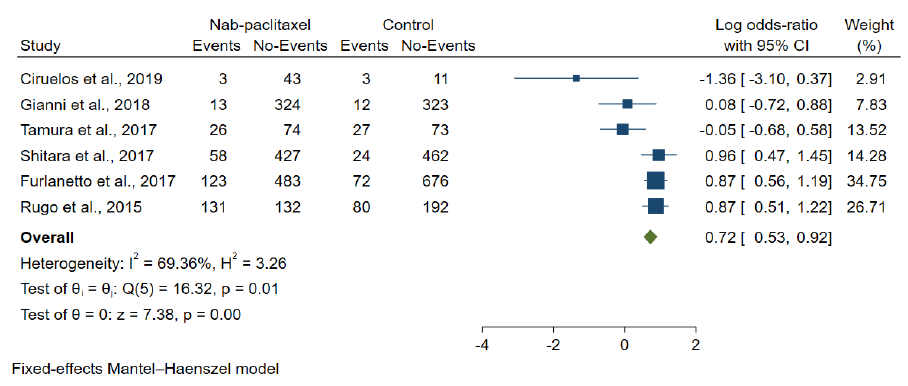
Fig. 2. The forest plot showed the odds ratio of treatment termination due to adverse events.